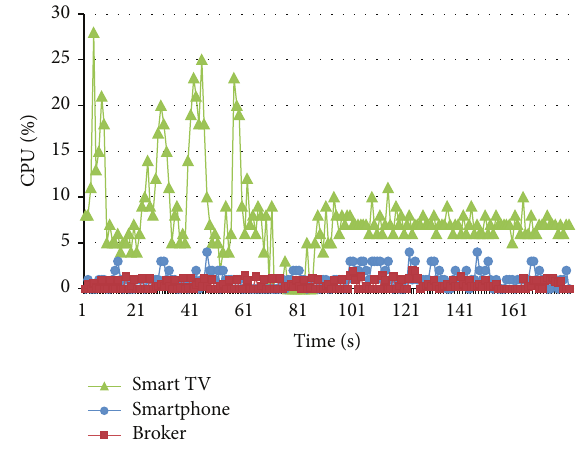
Figure 17: Online test CPU consumption.